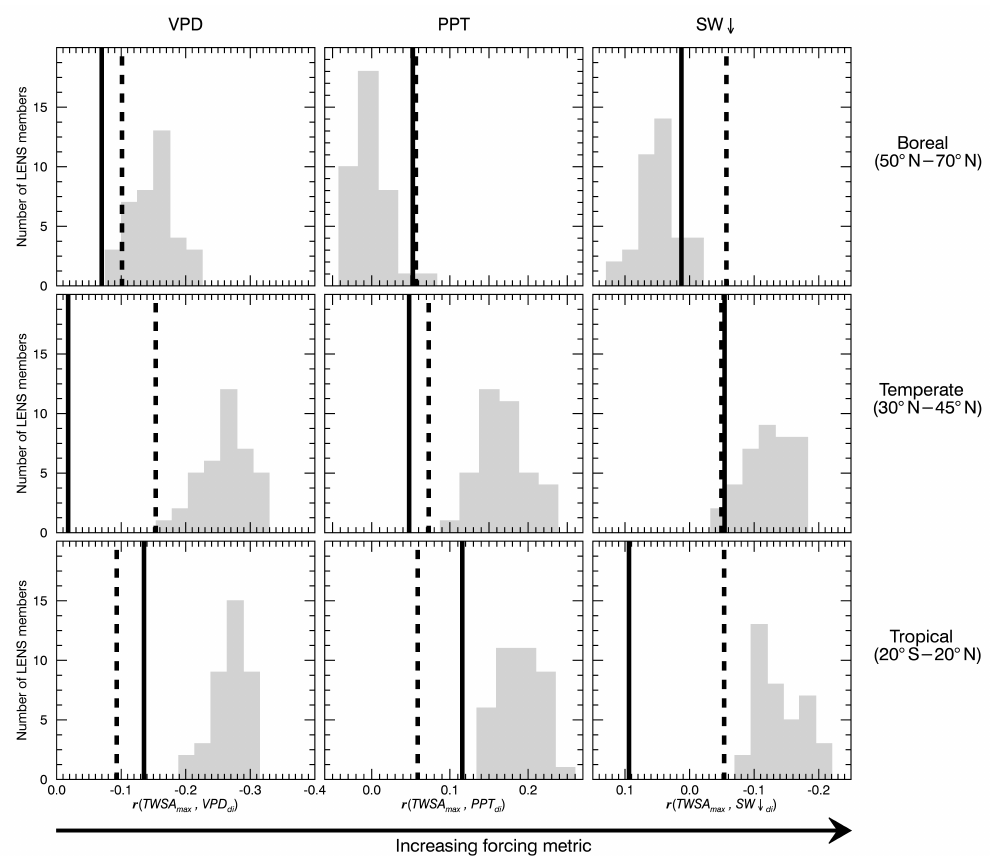
Figure 8. Ensemble histogram of forcing metrics from the 38 simulations in LENS (gray bars) compared to satellite observations from GRACE/AIRS/GPCP/CERES (solid black line) and the alternate set of observations from GRACE and ERA-Interim (dashed black line), averaged across land regions within different latitude